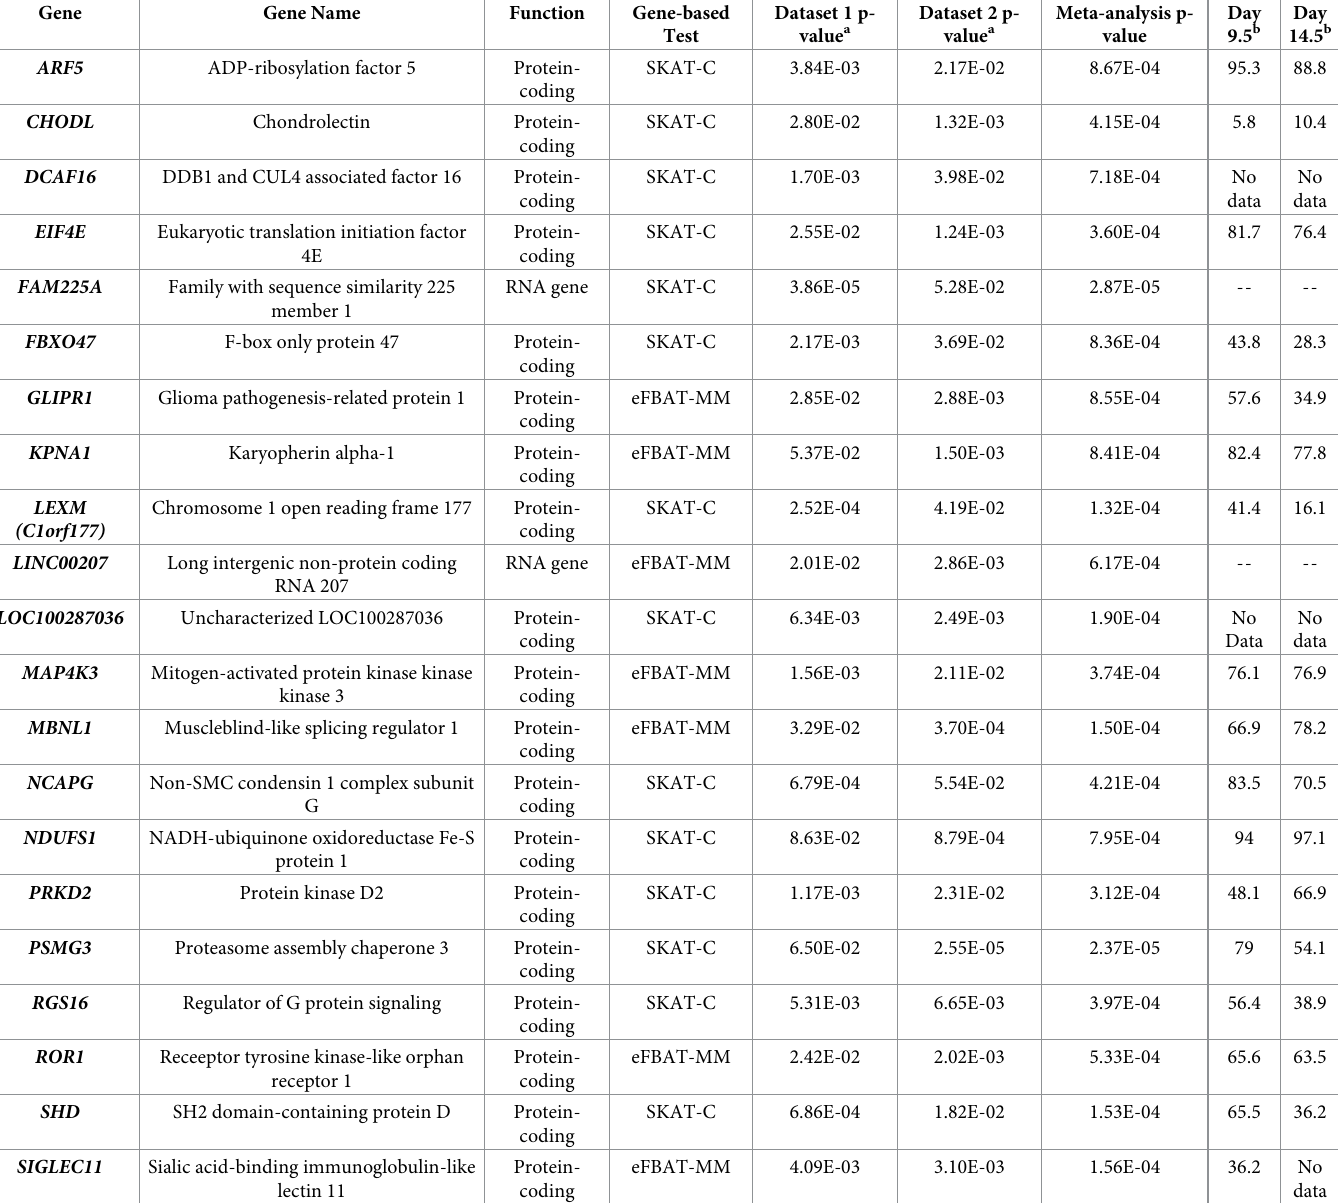
Table 5. Genes with suggestive evidence of association (p < 1E-03) in either dataset and with a meta-analysis p-value that is lower than that obtained in either of the contributing